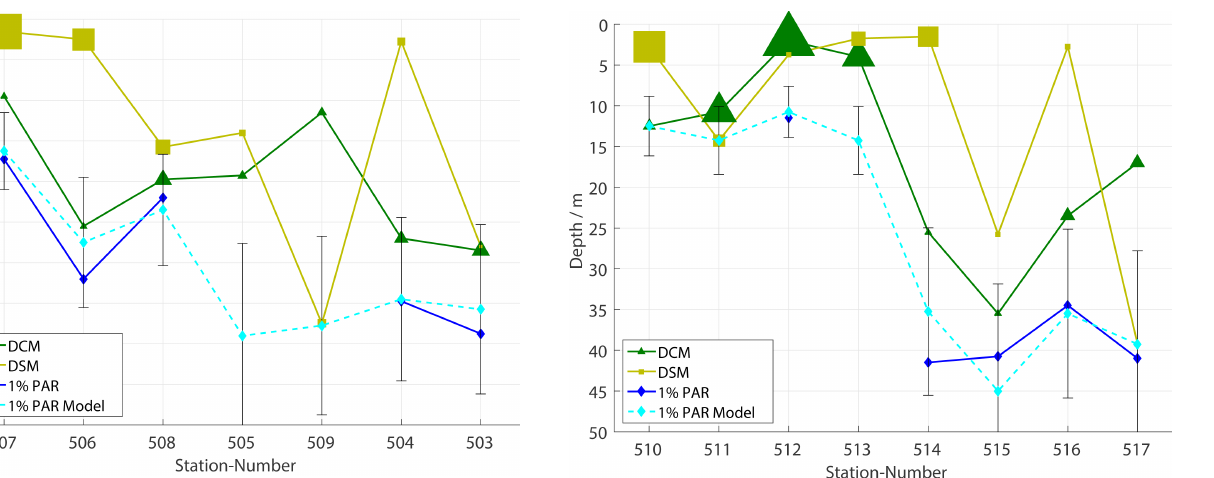
Figure 9. DCM (green, deep chlorophyll max.) and DSM (ocher, deep SPMi max.) at stations in the Vaigat (510–513) and Disko Bay (514–517). The size of the markers represents the sum of Chl and SPMi concentrations from the top of the water column to the mod- eled 1% depth. Measured 1% PAR (blue) where available and mod- eled 1% PAR as the dashed line